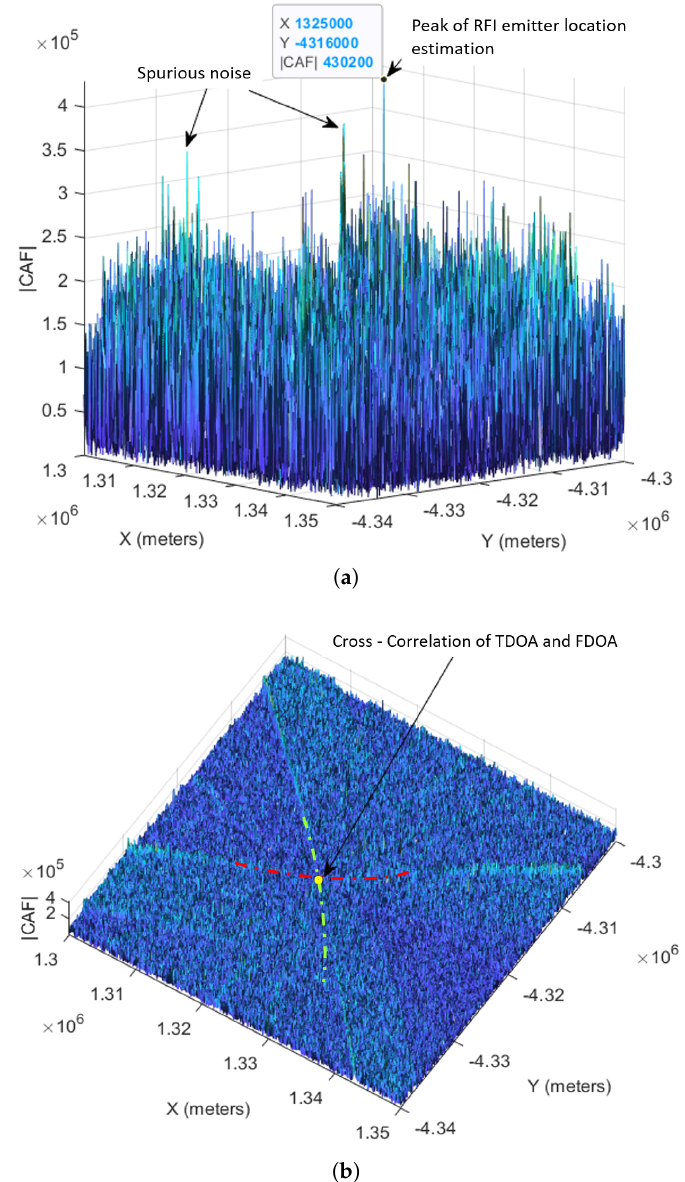
Figure 12. Snapshot of CAF peak and cross-correlation for RFI emitter location estimation. ( a ) CAF peak of RFI emitter estimation. ( b ) Cross-correlation of TDOA and